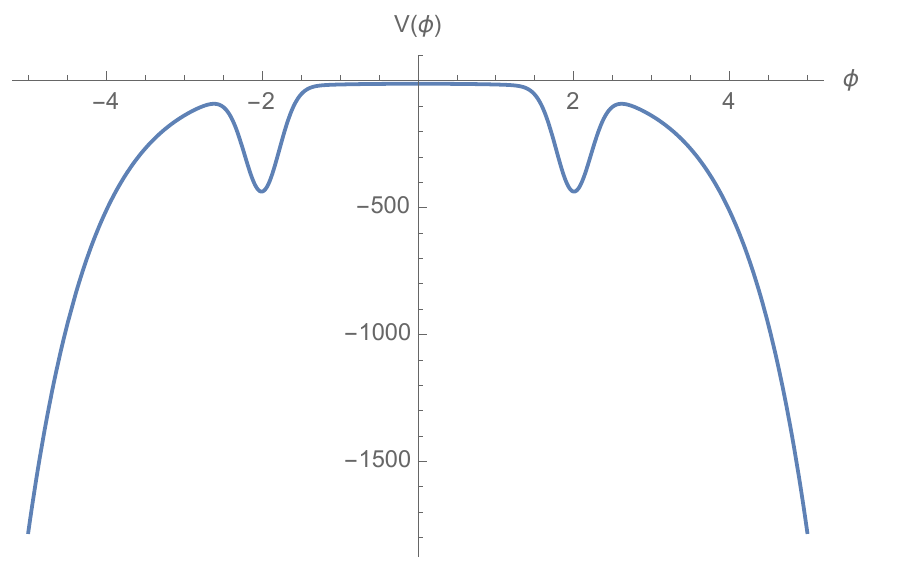
p 3 , c = 400, (cid:27) = 1 = 20.